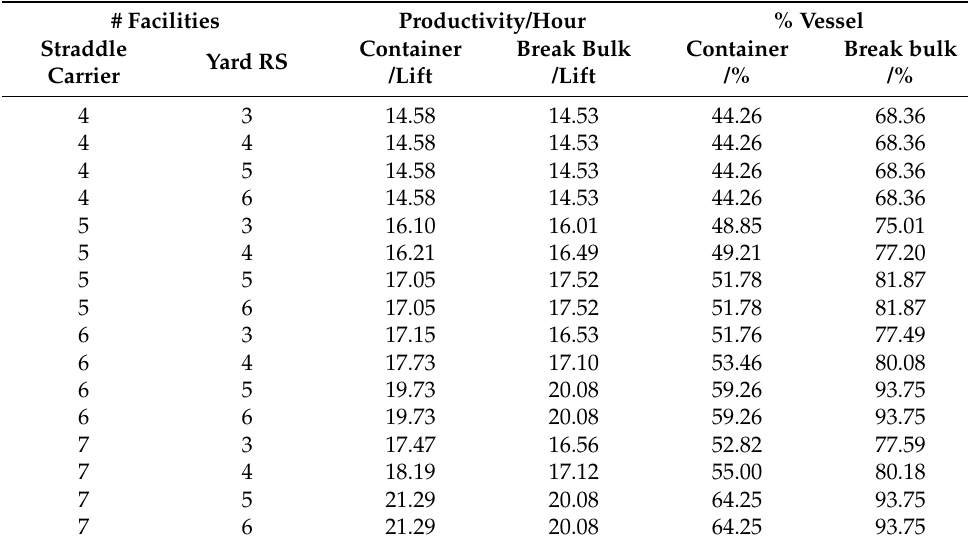
Figure 13. Simulation scenario for straddle carriers. Table 3. Result of